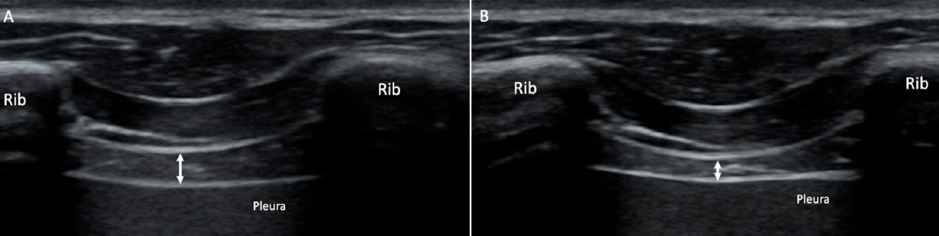
Figure 3. B-mode ultrasound imaging of the diaphragm thickness showing the last intercostal space at the mid-axillary line from the upper edge of the 12th rib to the lower edge of the 11th rib of the thorax. ( A ) Diaphragm thickness measurement marked by a white arrow at maximum inspiration (T ins ) during normal breathing. ( B ) Diaphragm thickness measurement marked by a white arrow at maximum expiration (T exp ) during normal breathing.